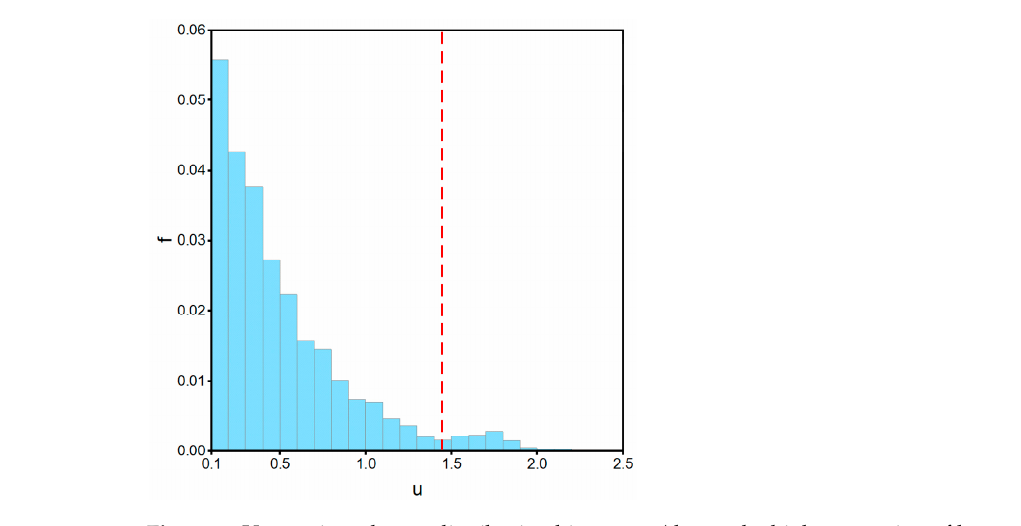
Figure 6. Uncertainty degree distribution histogram (due to the high proportion of known pixels, the leftmost part of the histogram is omitted to achieve a better display effect). Algorithm 1. The selection of the threshold algorithm.